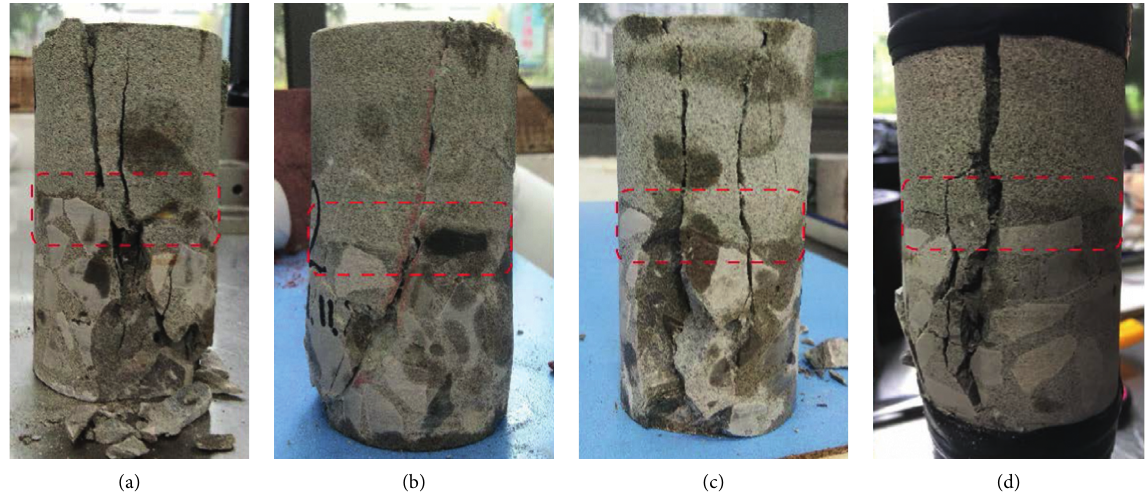
Figure 8: Failure mode of rock-concrete composite specimen under different confining pressures. (a) 0MPa. (b) 7MPa. (c) 15MPa. (d) 22MPa.